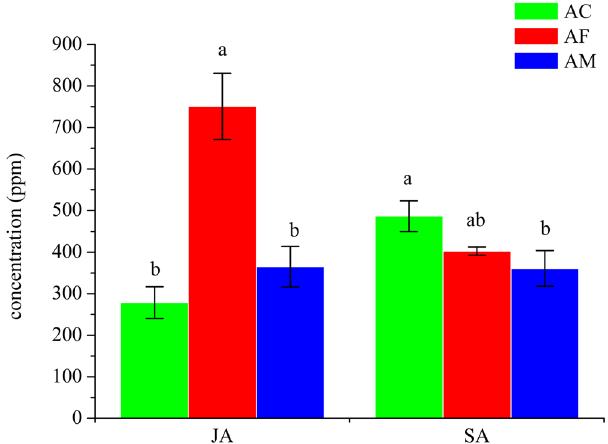
Figure 5. SA and JA concentrations in AC (green), AF (red) and AM (blue). All results were expressed as means ± standard error (SE) of the number of experiments. The lowercase ‘a’, ‘b’ and ‘ab’ indicated that statistically significant difference of concentration was considered on an error probability of p < 0.05 by one- way ANOVA using Duncan’s multiple-range